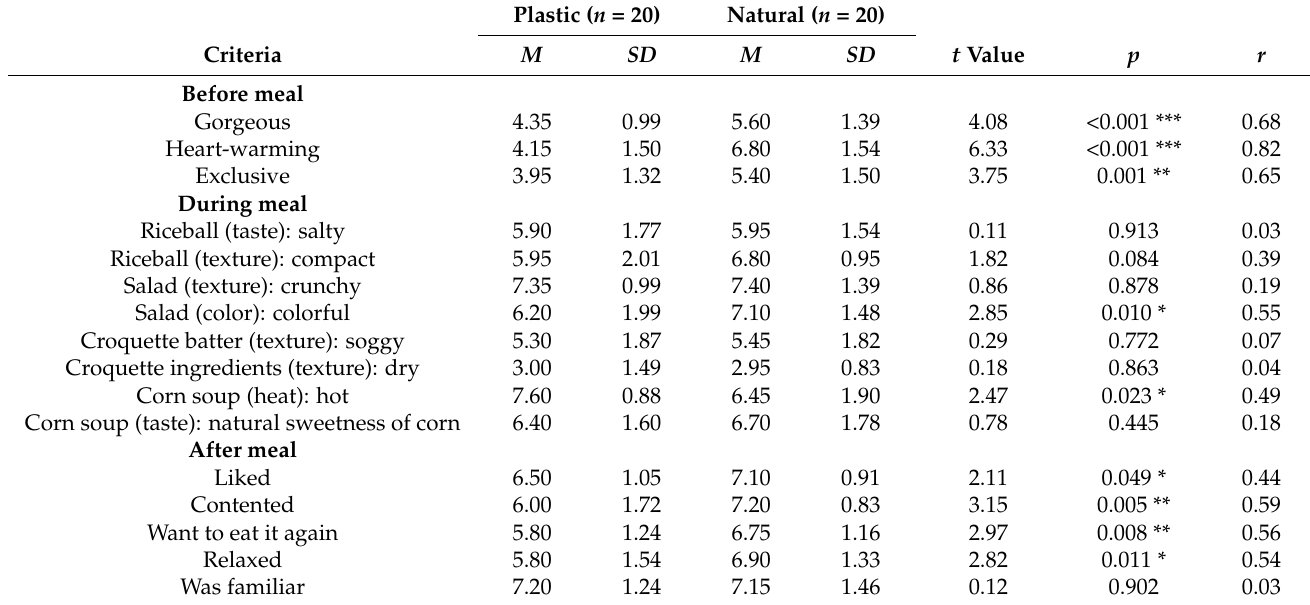
Table 2. Descriptive statics and comparison between plastic and natural tableware